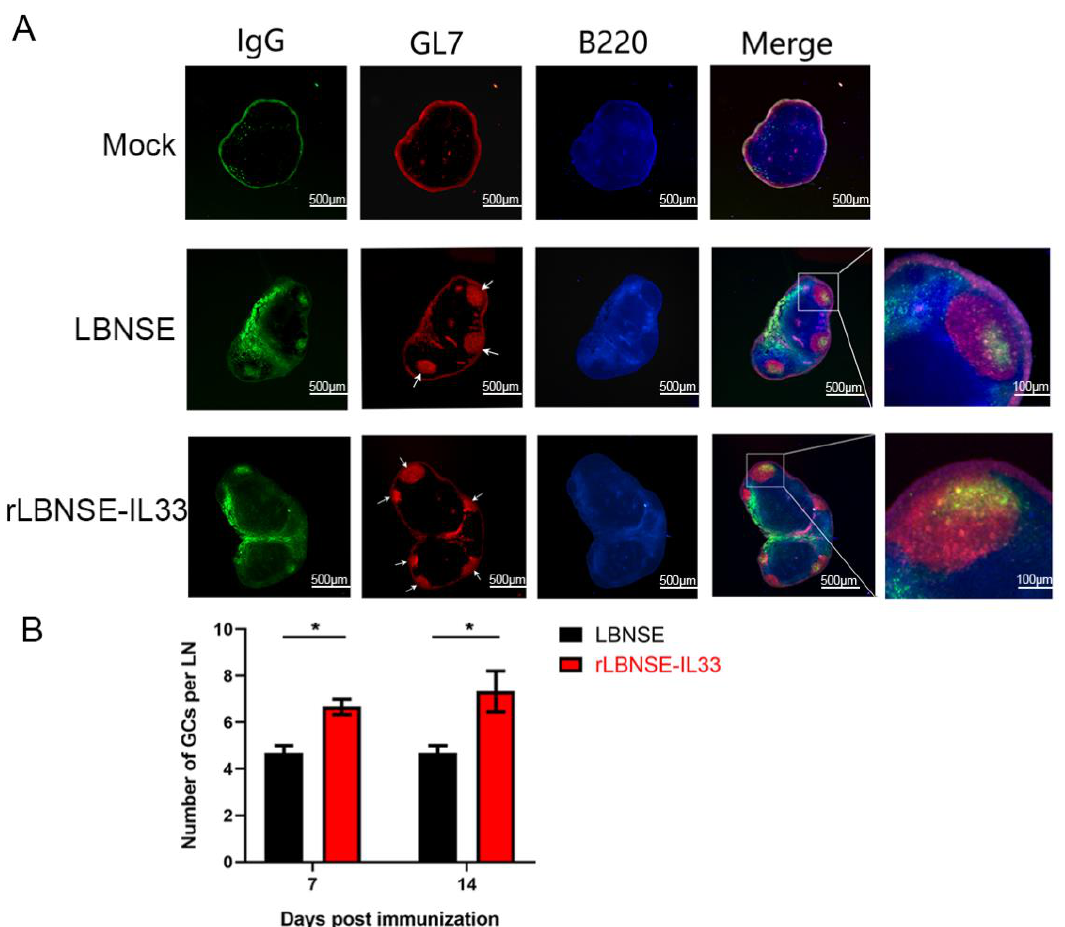
Figure 7. Overexpression of IL-33 in rRABV promotes the formation of GCs. Six-week-old female BALB/c mice were vaccinated via i.m. route with 10 6 FFU rRABVs or DMEM. The draining LNs were collected and stained (IgG, green; GL7, red; and B220, blue) for GC number detection: ( A ) representative results of immunofluorescence represented GCs in LNs; ( B ) number of GCs per LN was counted at 7 and 14 dpi. The standard error (SE, n = 3) was illustrated by error bars, and the data were analyzed by unpaired two-tailed t-test. Significant differences between groups were indicated at the levels: *, p < 0.05.